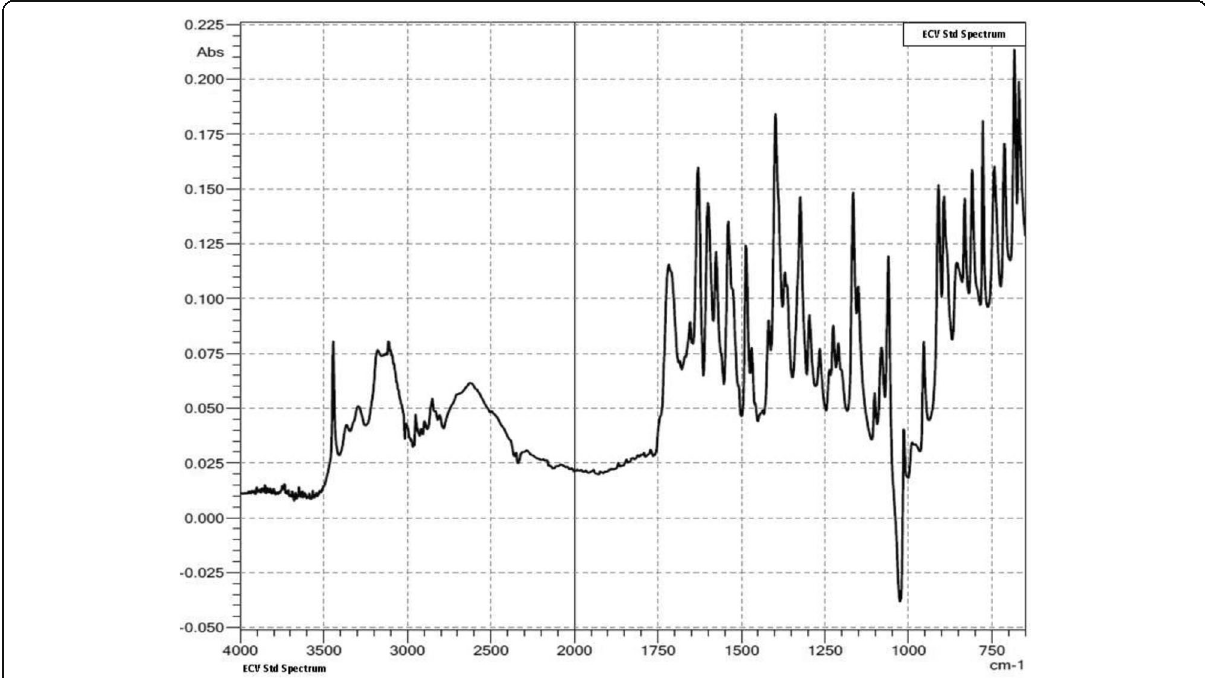
Fig. 2 FT-IR spectrum of entecavir